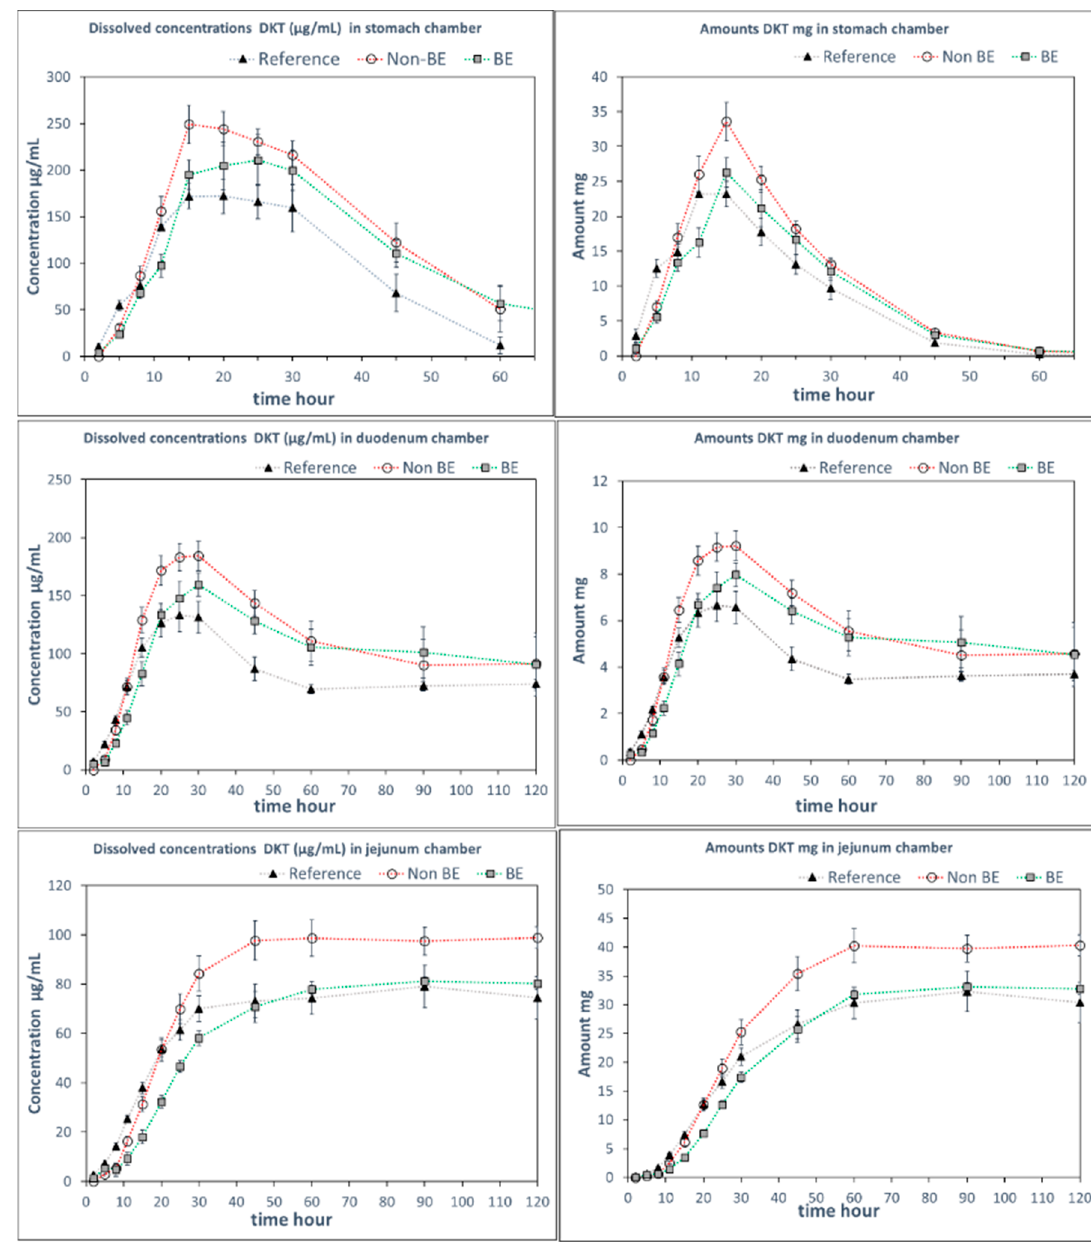
Figure 4. DKT concentrations ( left panels ) and amounts in solution ( right panels ) in the GIS stomach , GIS duodenum , and GIS jejunum vessels obtained with Protocol 2 with NaCl in GIS stomach at 34 mM and FaSSIF-v1 in the duodenal chamber. Experimental data were shown as mean ± SD (n = 4). Dotted lines are included to facilitate visual profile comparison.